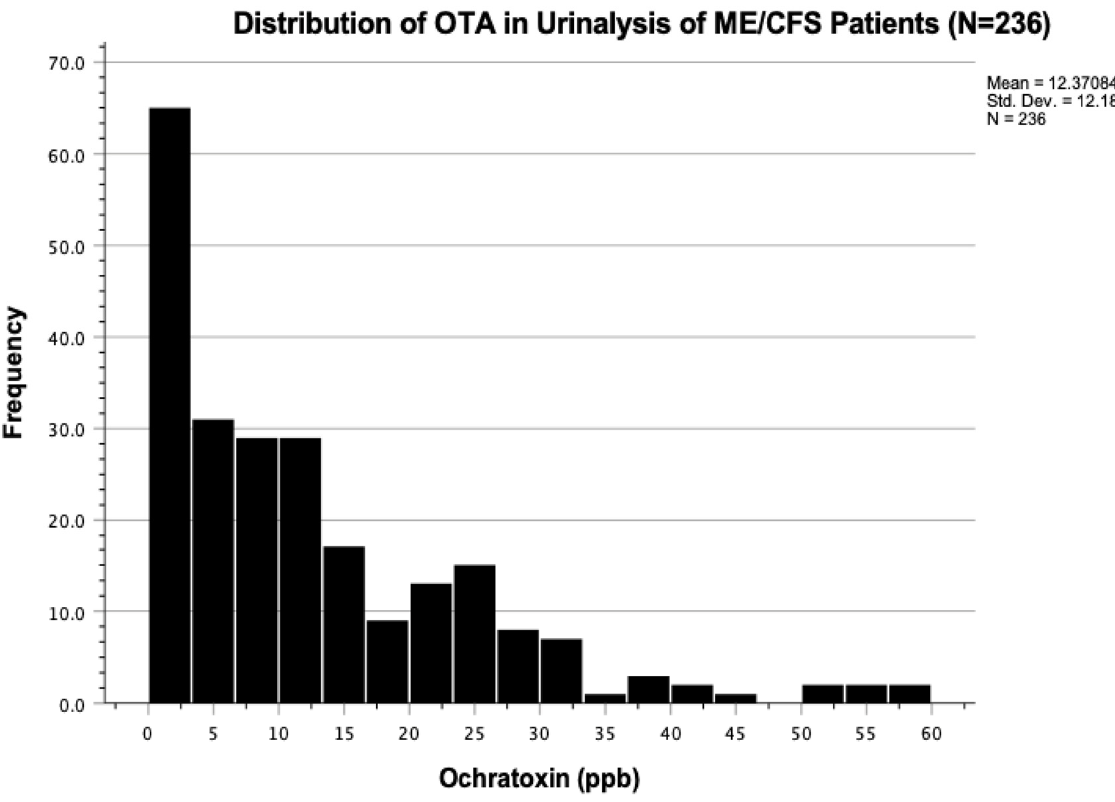
Figure 4. Ochratoxin A in urinalysis of 236 ME/CFS patients with chronic exposure to mold showed a right-skewed distribution with mean OTA levels of 12.37 ± 12.18 ppb.